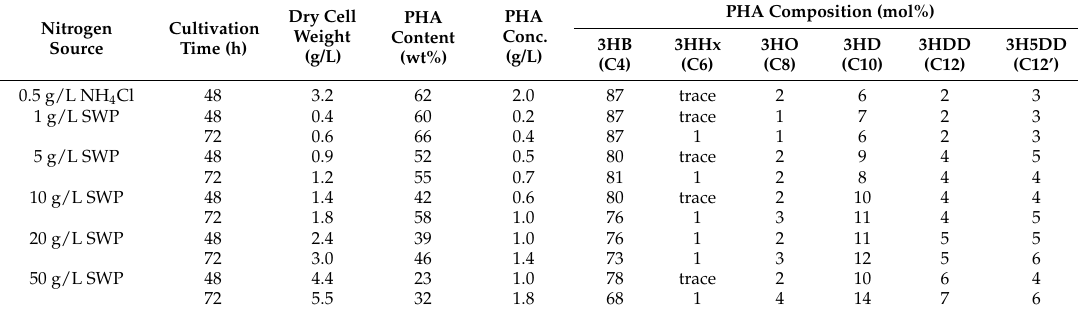
Table 2. Biosynthesis of PHA Pseudomonas sp. 61-3 ( phbC :: tet ) harboring pJKSc54- phab from SWP as the sole nitrogen